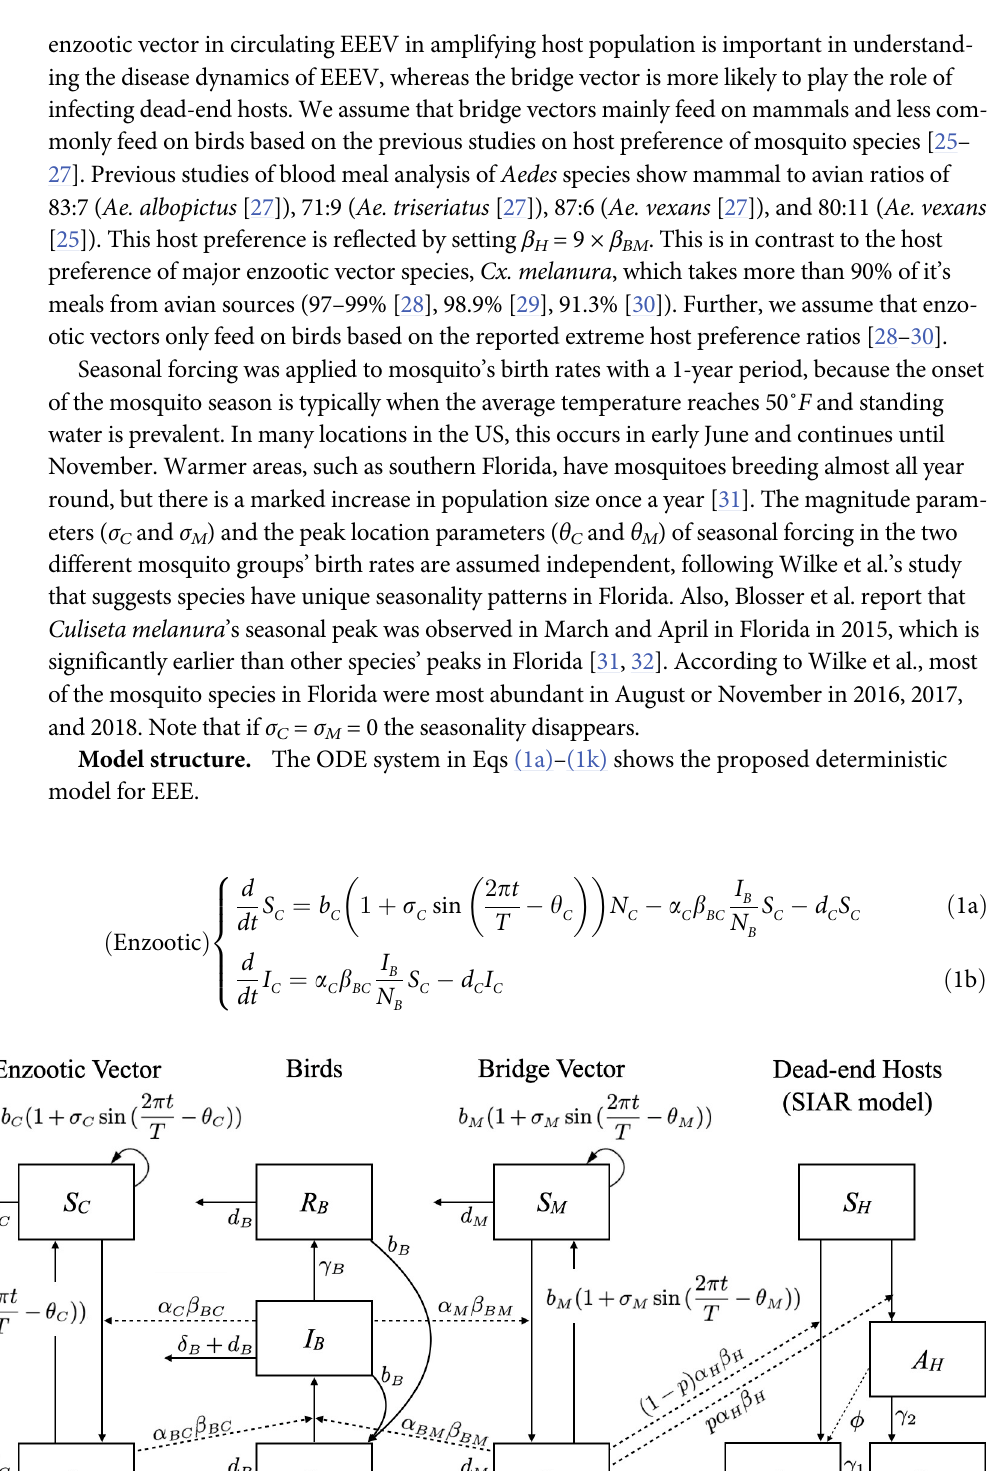
PLOS ONE | https://doi.org/10.1371/journal.pone.0272130 August 17,